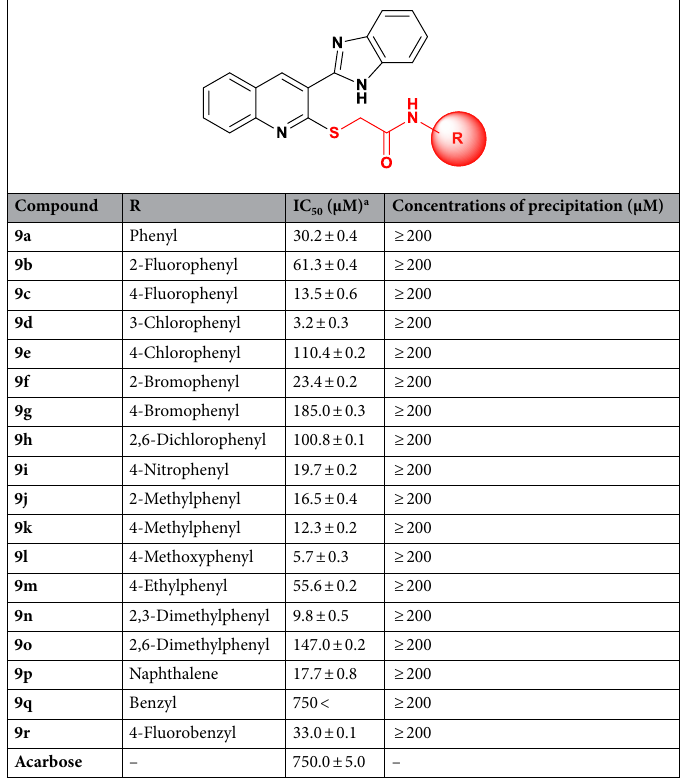
Table 1. α-Glucosidase inhibitory activity of compounds 9a–r . a Data represented in terms of mean ±